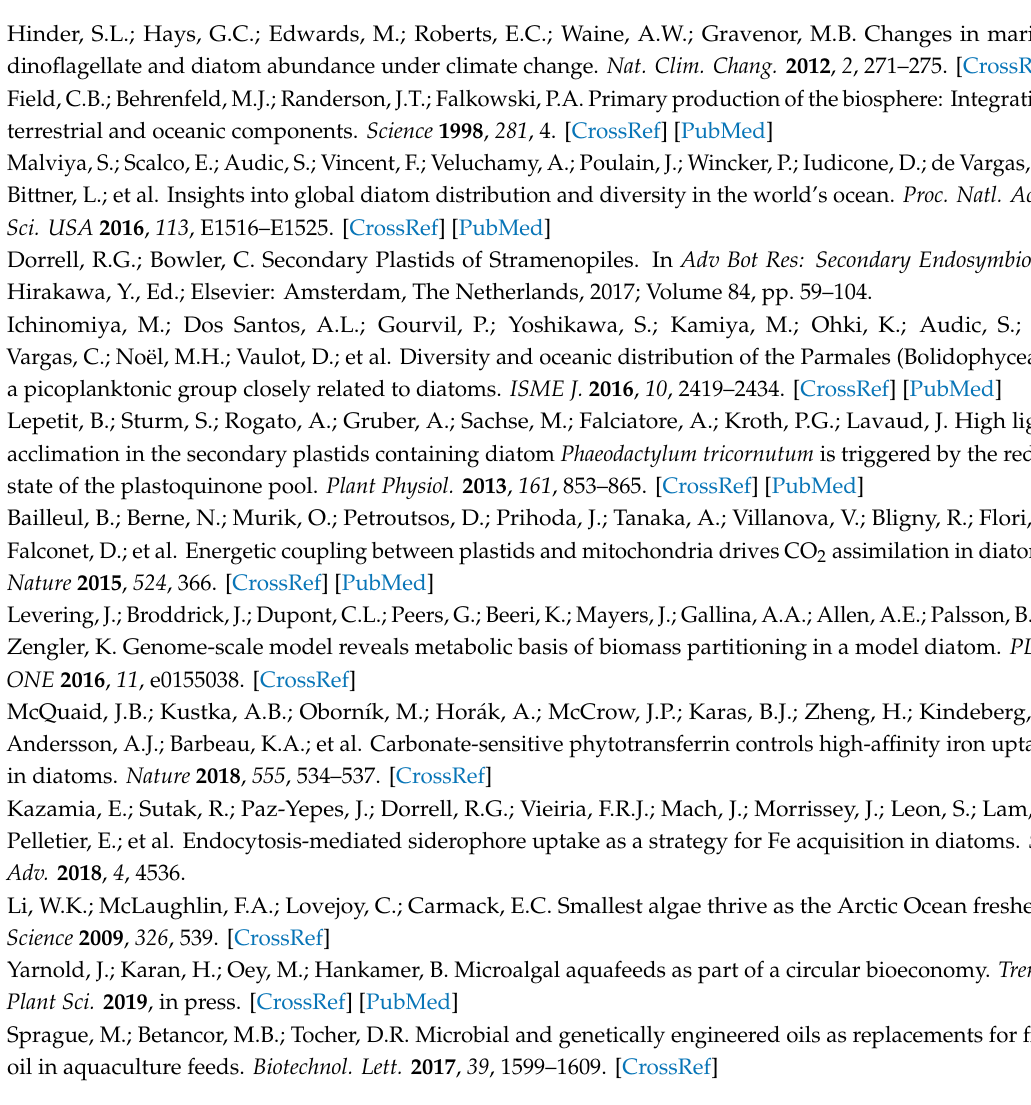
Figure S1: Experimental localisations of diatom ornithine cycle enzymes, Figure S2: Evolutionary distribution and localisation of diatom theta-carbonic anhydrases, Figure S3: Evolutionary distributions of diatom iota-carbonic anhydrases, Figure S4: Chloroplast targeting sequence of Fistulifera solaris chloroplast proteins, Table S1: Overview of plastid protein content across diatom and related algal lineages, Table S2: Evolutionary and subcellular distributions of diatom carbonic anhydrases, Table S3: Tabulated sequences of Fistulifera and other diatom chloroplast pyruvate hub, branched chain amino-acid, and isoprenoid-associated synthesis enzymes. Funding: This research was funded by a CNRS Momentum Fellowship to RGD, and a JSPS PhD studentship to TN. The APC was funded by Tokyo University of Agriculture and Technology. Conflicts of Interest: The authors declare no conflict of